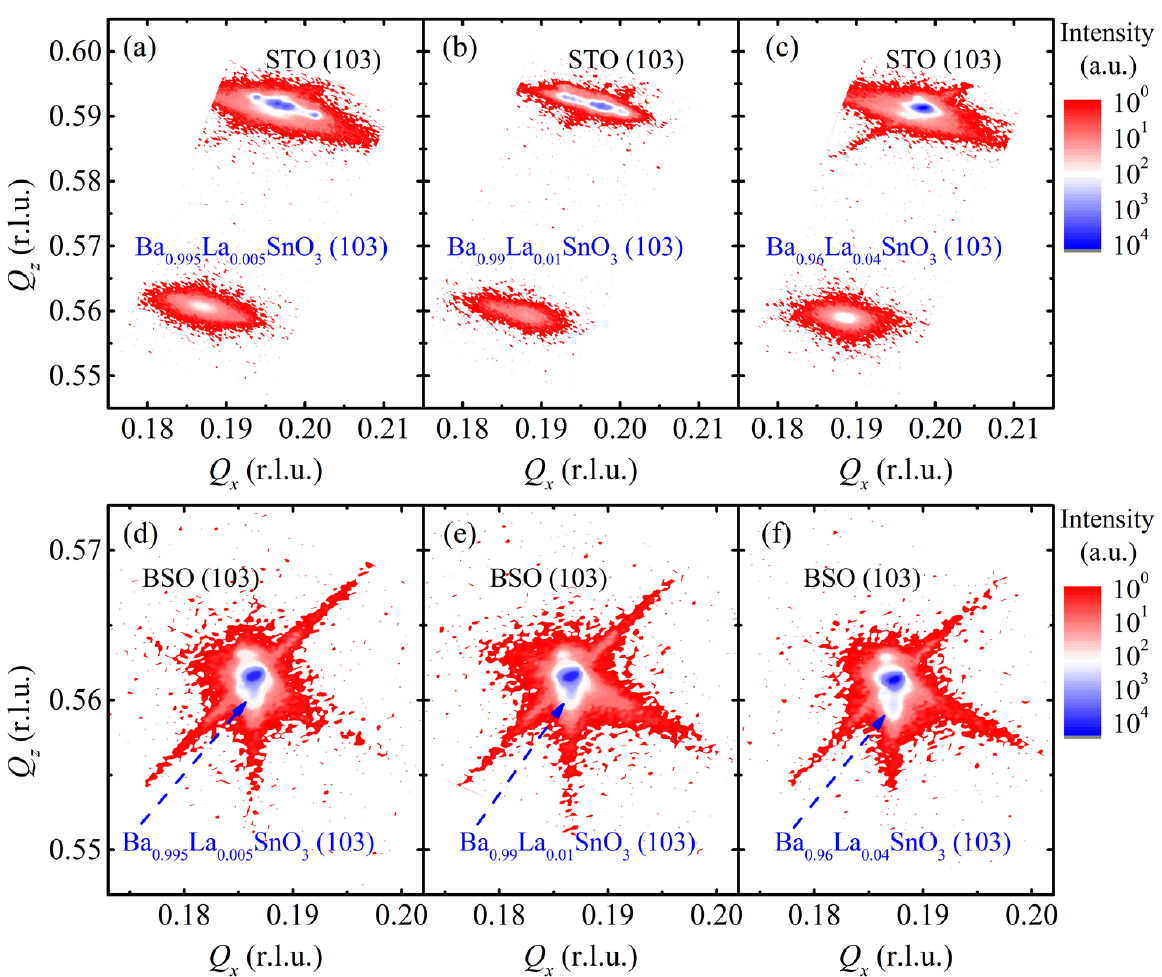
Figure 1. The reciprocal space mapping (RSM) data of Ba 1 – x La x SnO 3 ( x = 0.005, 0.01, 0.04) films grown on ( a – c ) STO (001) and ( d – f ) BSO (001) subtrates, all of which were taken near the (103) peaks.